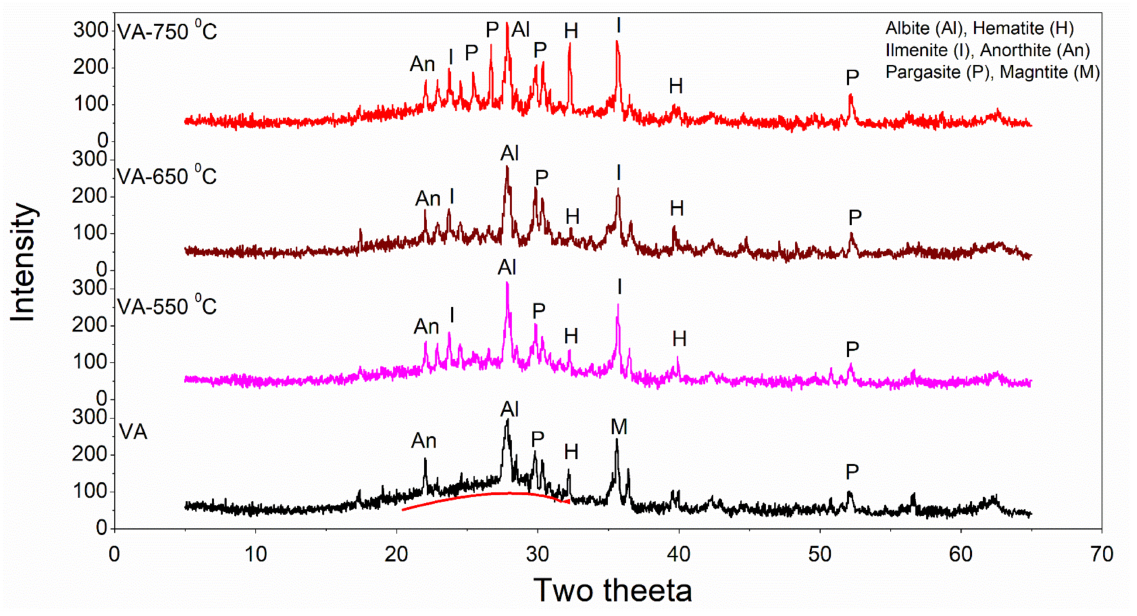
Figure 4. XRD patterns of fine volcanic ash (VA) before and after heat treatment at different temperatures.